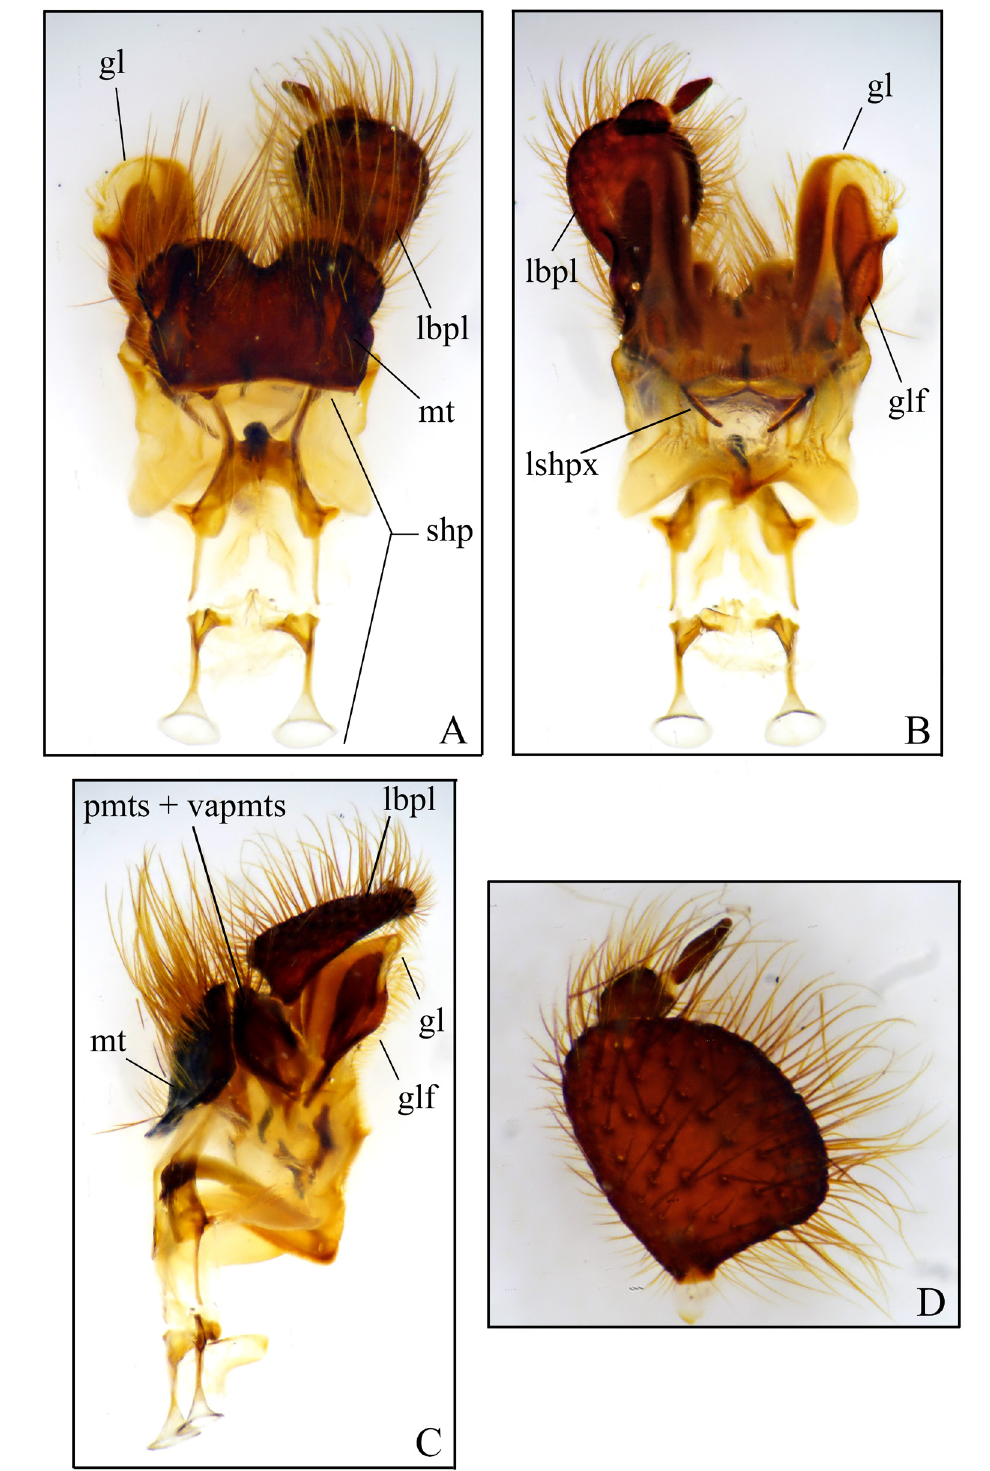
Fig. 11. Labium of Streblopus opatroides van Lansberge, 1874 (left palpus removed). A . Ventral view (aboral surface). B . Dorsal view (oral surface). C . Lateral view. D . Removed left palpus. Note the unusual shape of the palpus, with the basal palpomere remarkably enlarged. Abbreviations: gl = glossa; glf = glossal flap; lbpl = labial palp; lshpx = lateral hypopharyngeal sclerite; mt = mentum; pmts = premental sclerite; shp = suspensorium of hypopharynx; vapmts = ventral angles of premental